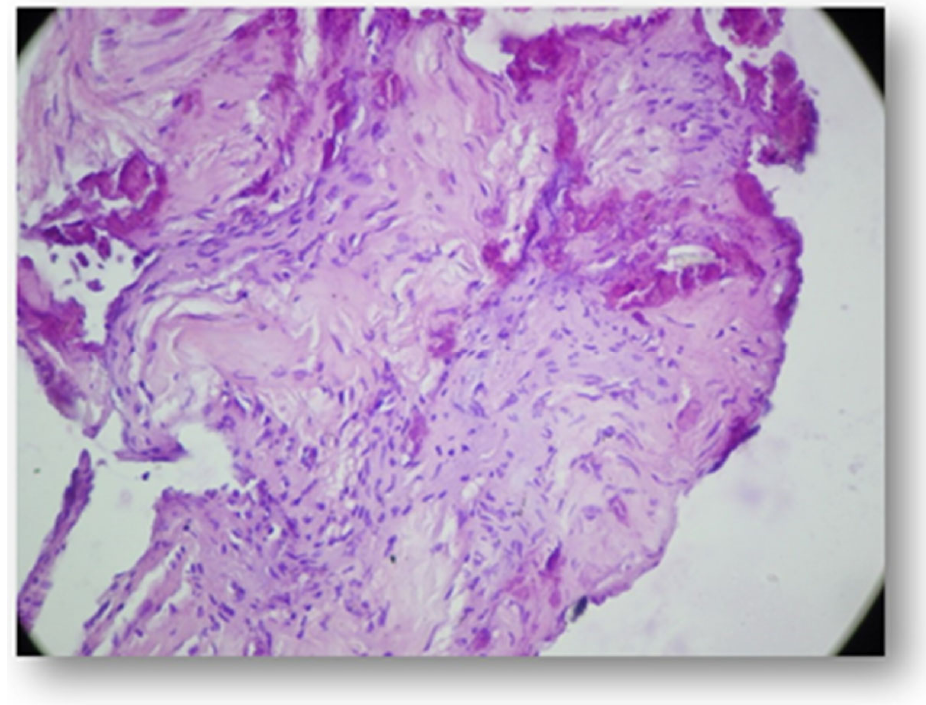
Figure 4. Dental pulp aspect (coronal pulp) of a 49 year old male, type 2 diabetes, HE staining, ×100.